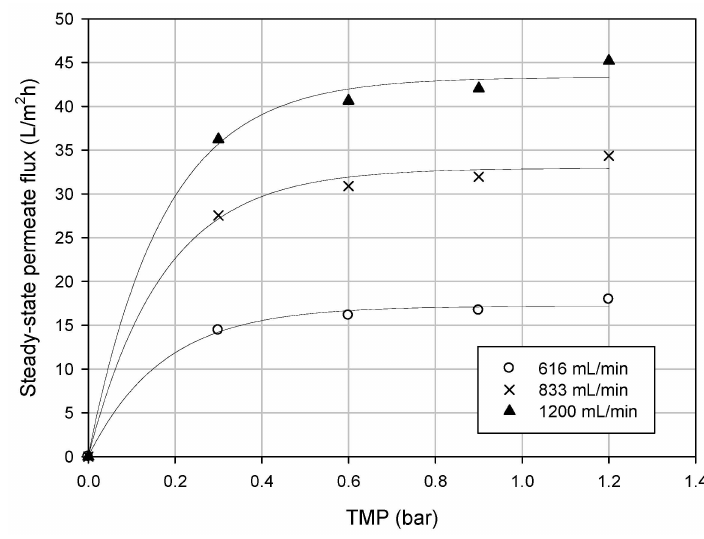
Figure 2. Effect of transmembrane pressure on steady-state permeate flux at different feed flow rate (operating temperature, 25 ˝